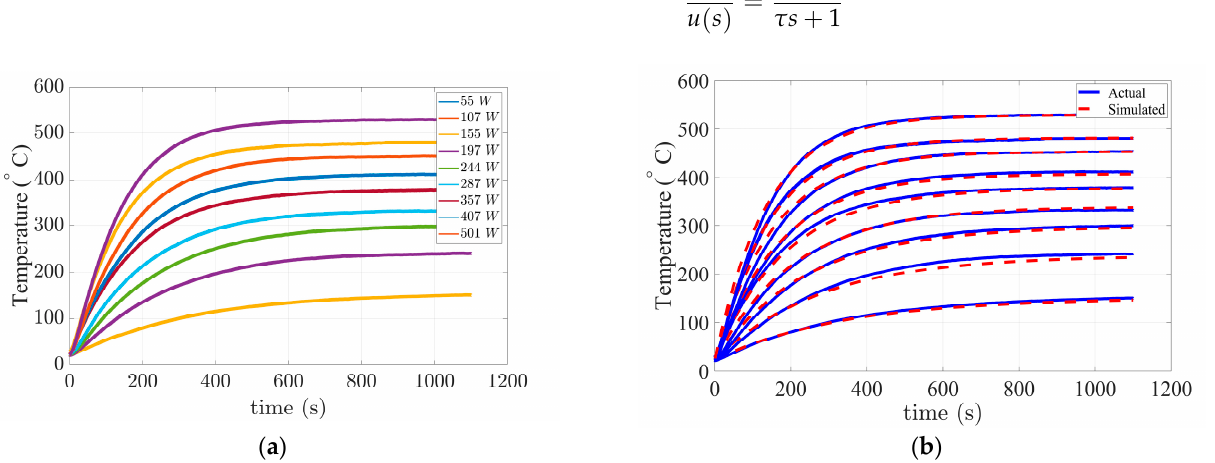
Figure 7. ( a ) Actual heater surface temperature variation over time for different power levels; ( b ) comparison the simulated and actual surface temperatures variation over time in different power consumption.